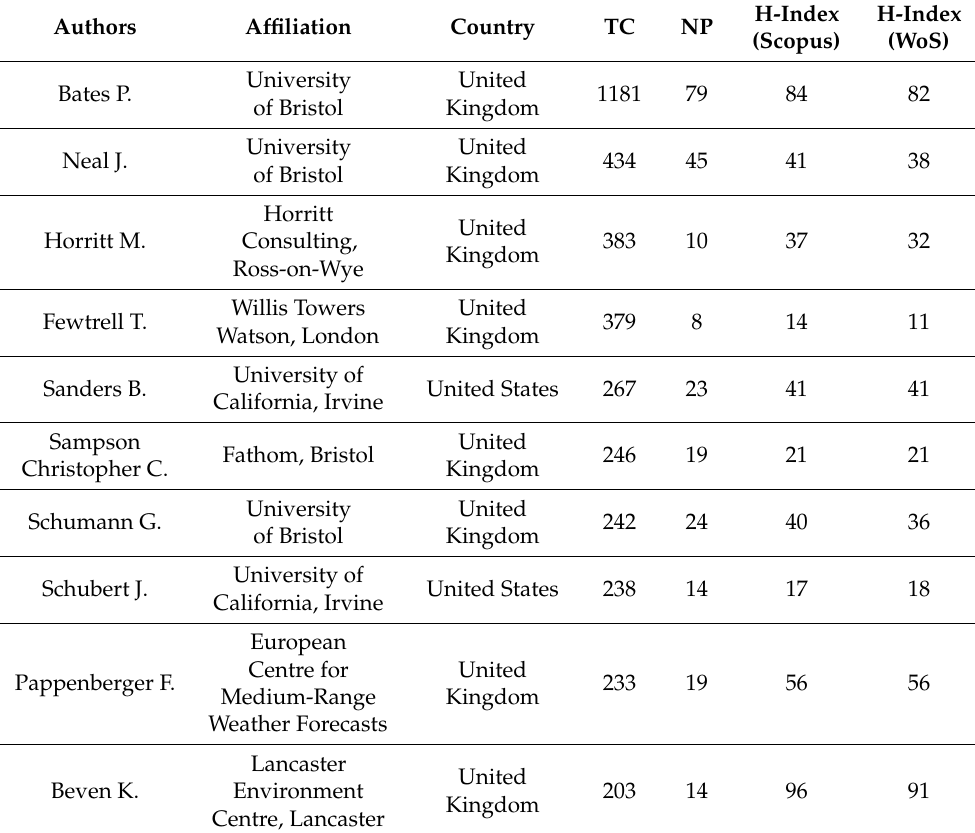
Table 5. Leading authors by the number of citations in flood modelling. Total Cites (TC) and Number of Publications